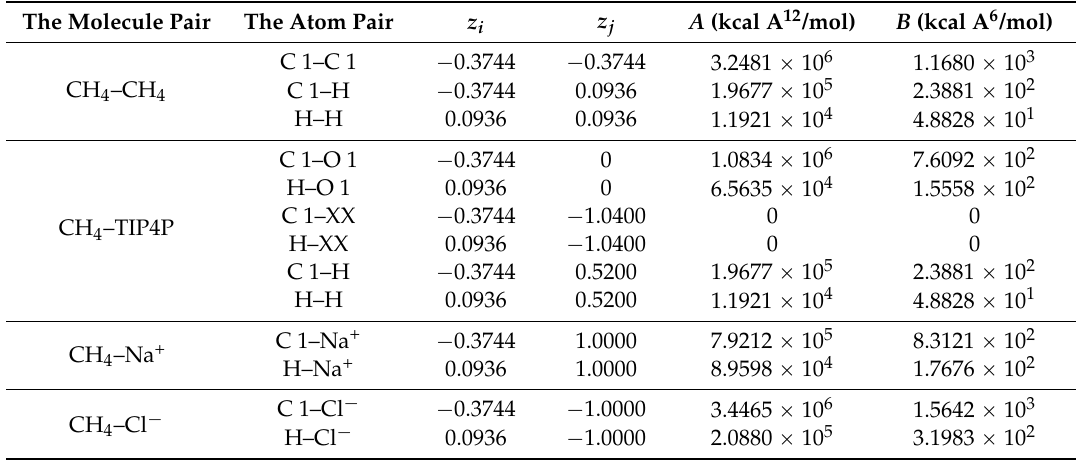
Table 12. The potential parameters between CH 4 –CH 4 , TIP4P–CH 4 , Na + –CH 4 , and Cl ´ –CH 4 . The Molecule Pair The Atom